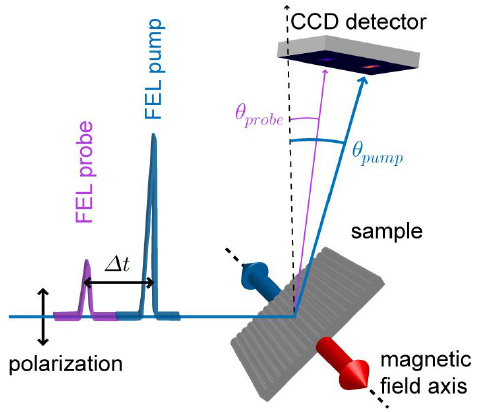
Figure 2. Schematics of the scattering measurement setup. The grating samples are mounted in a reflectometer featuring a vertical scattering plane. A magnetic field (up to 1.5 kOe pulsed, 500 Oe permanent) can be applied normal to the scattering plane and parallel to the sample surface by a horseshoe electromagnet. The FEL pulses with linear vertical polarization impinge on the sample grating at 46.5° and are diffracted at different angles according to their wavelengths. Diffracted intensities from the pump and probe FEL pulses are collected simultaneously by using a two-dimensional charge-coupled device detector.